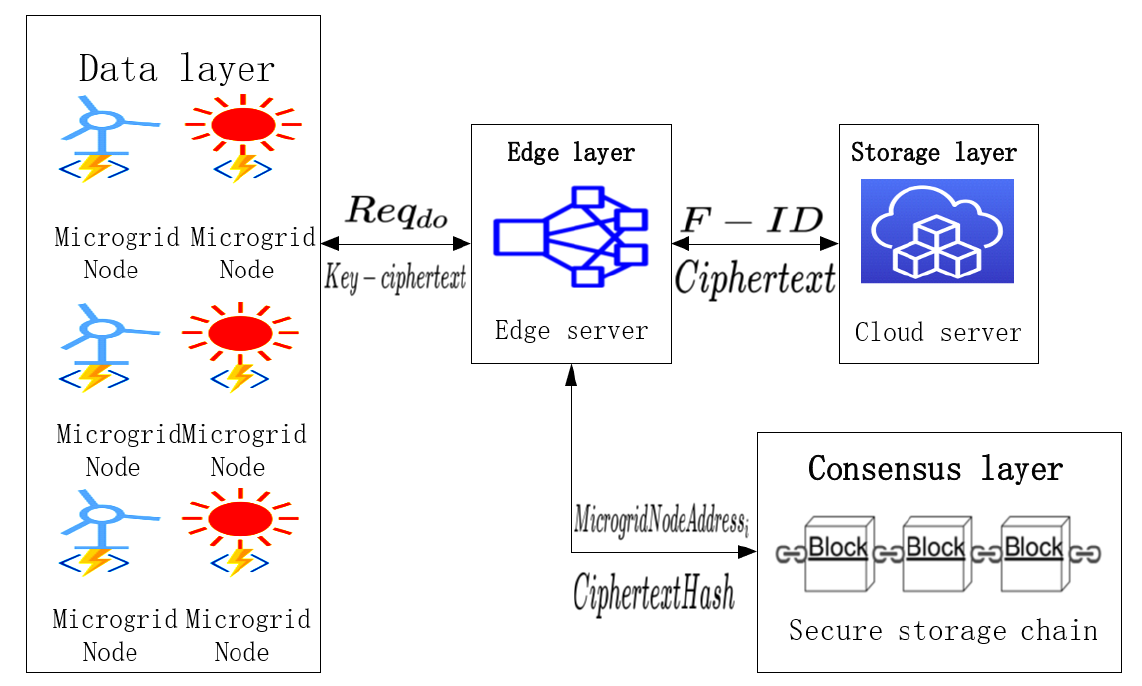
Figure 2. Process of secure storage.